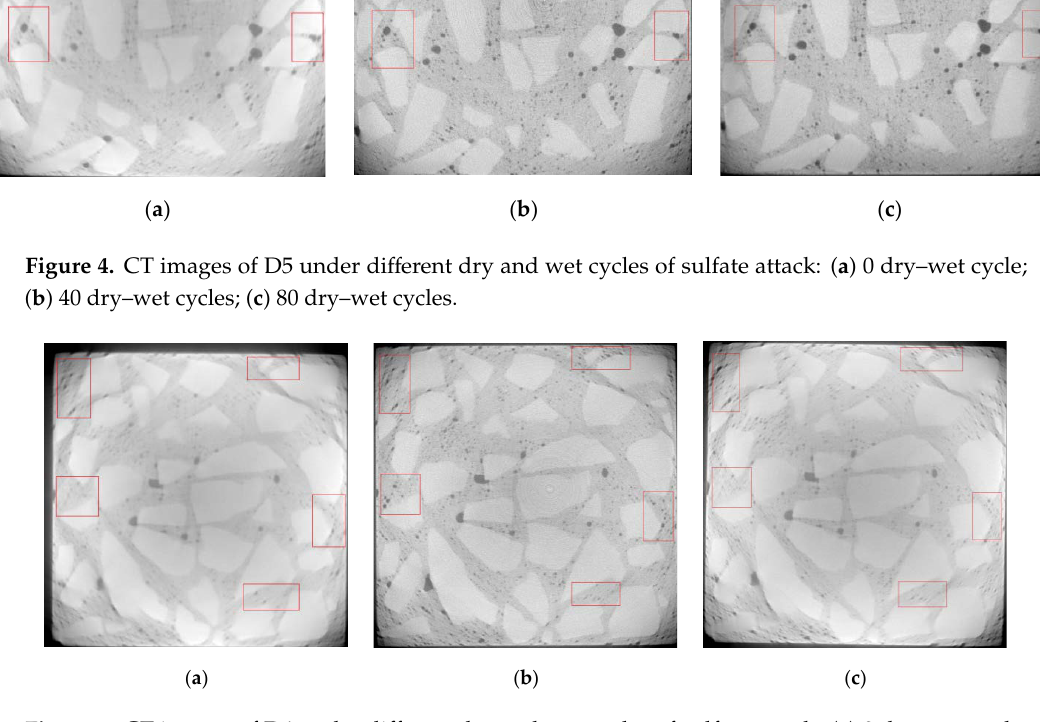
Figure 5. CT images of D4 under different dry and wet cycles of sulfate attack: ( a ) 0 dry–wet cycle; ( b ) 40 dry–wet cycles; ( c ) 80 dry–wet cycles.